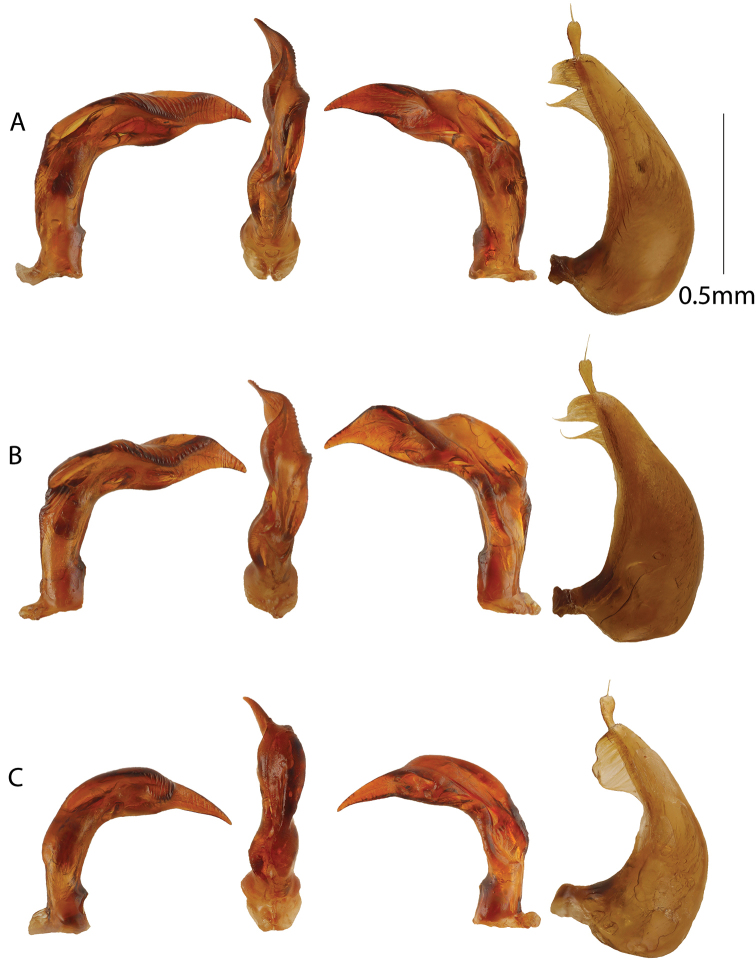
Male genitalia. From left to right aedeagus in right lateral, ventral, left lateral views, and left paramere. ACopelatus
amphibius sp. nov. BCopelatus
zanatanensis sp. nov. CCopelatus
betampona sp. nov.